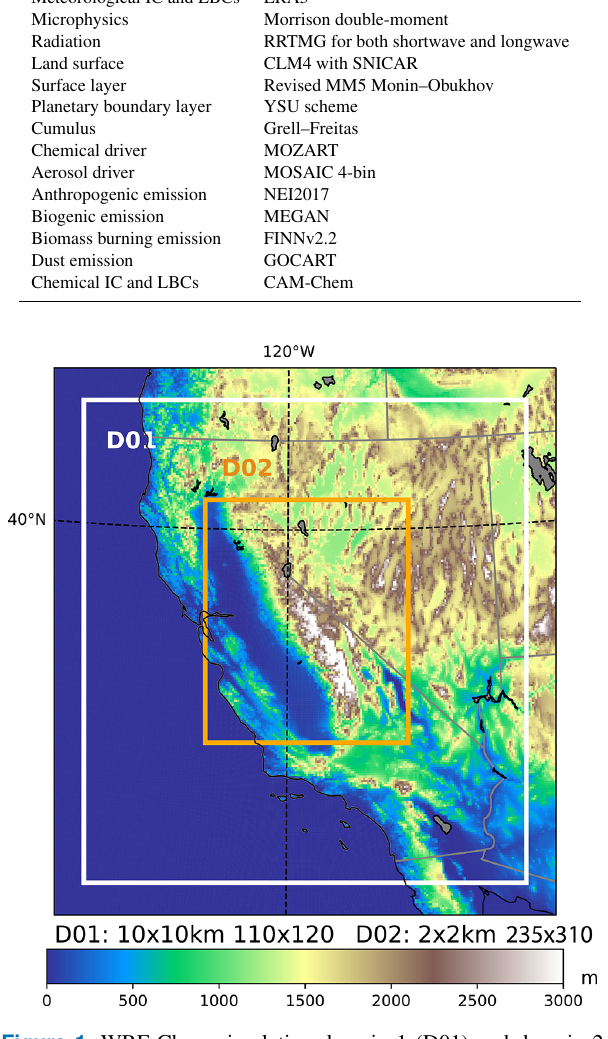
Figure 1. WRF-Chem simulation domain 1 (D01) and domain 2 (D02) used in this